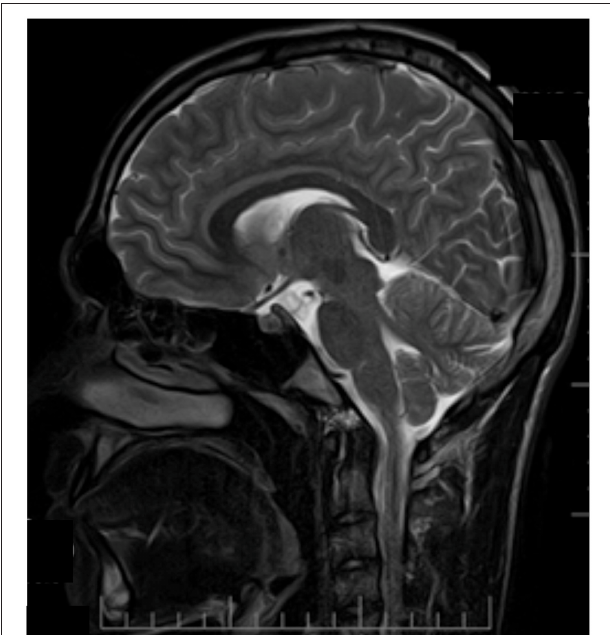
FIGURE 4 | MRI examination (T2 weighted sagittal image) of patient S. No signs of atrophy in cerebellum. Patient information and technical text were